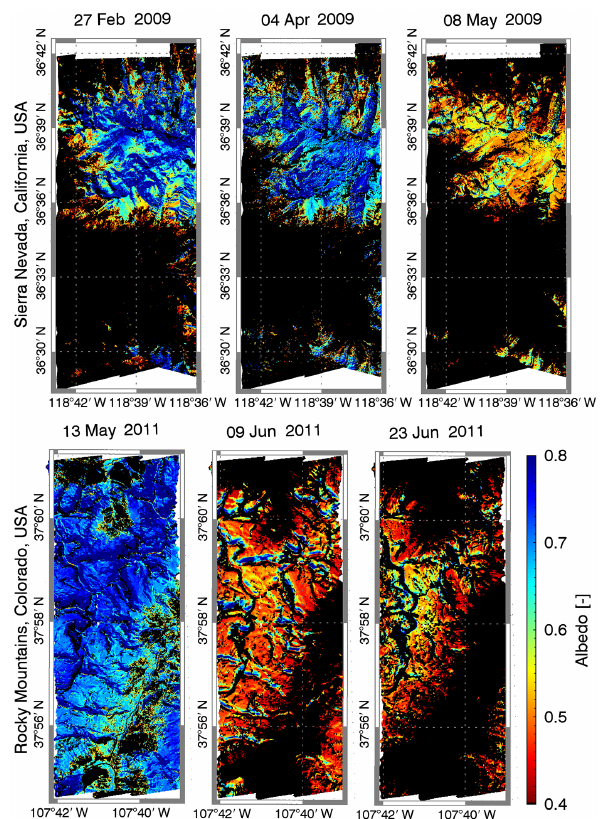
Figure 4. Maps of snow grain size retrieved using Eq. (4) for three dates during the melt period in the Sierra Nevada (upper panel), and the Rocky Mountains (lower panel). The upper and lower map represent 252 and 55km 2 , respectively (Table 1).